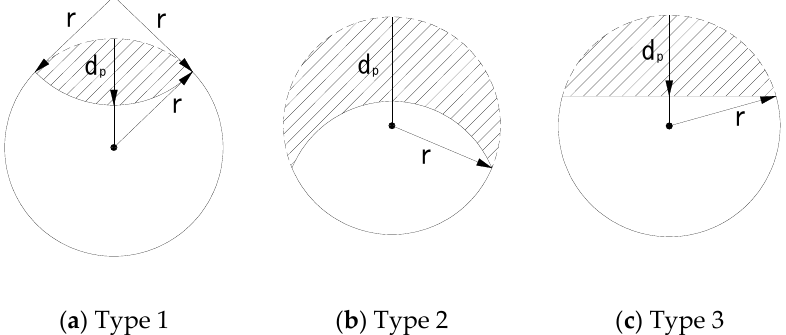
Figure 3. Corrosion of a strand near the anchor in Bridge B.